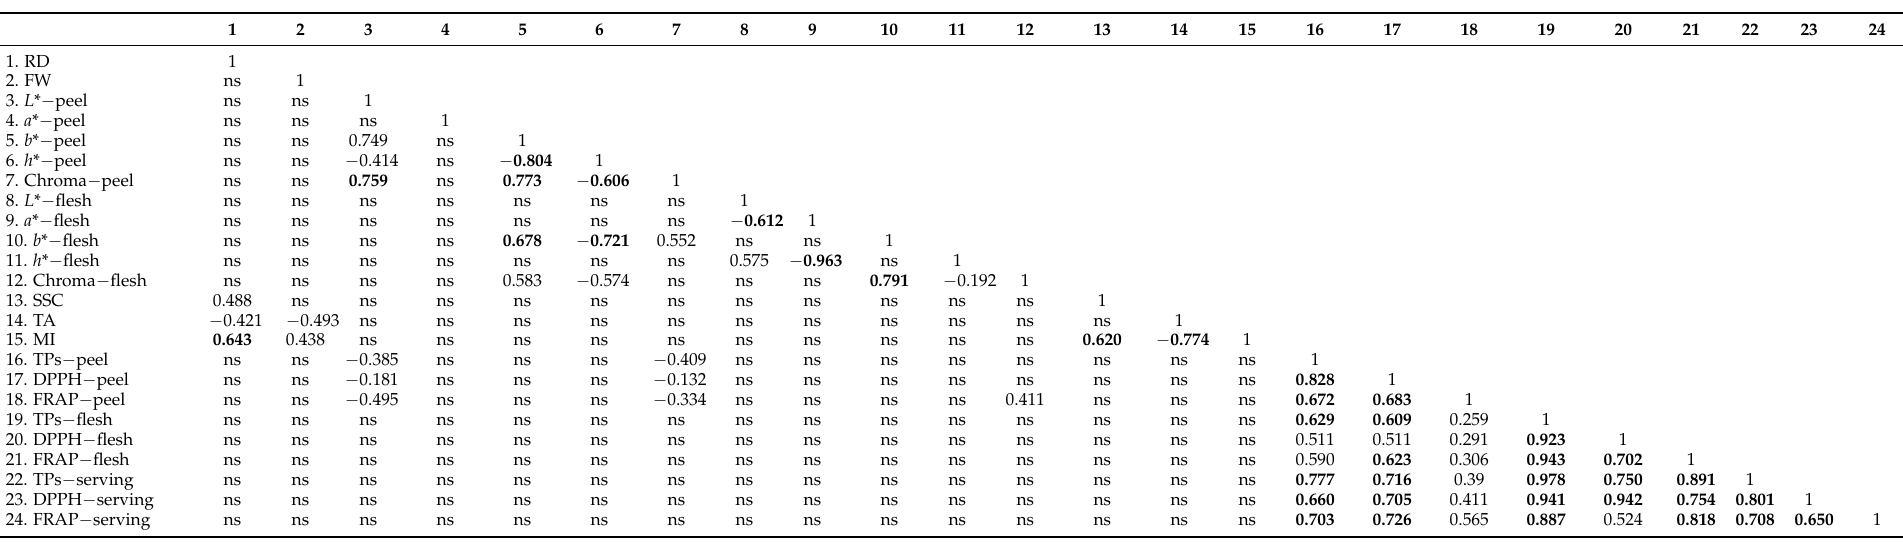
Table 4. Pearson correlation analyses between phenotypic and chemical traits in 24 Japanese plum cvs. Abbreviations as in Table